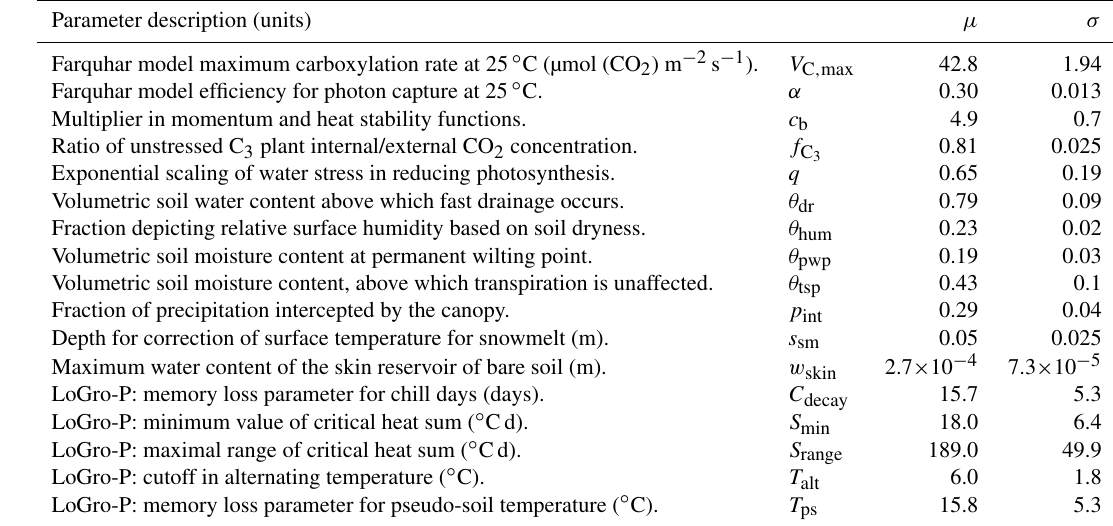
Table A2. PREBAS model parameter descriptions as in Minunno et al. (Table 1; 2019) with distribution mean and standard deviation. Parameter description (units)